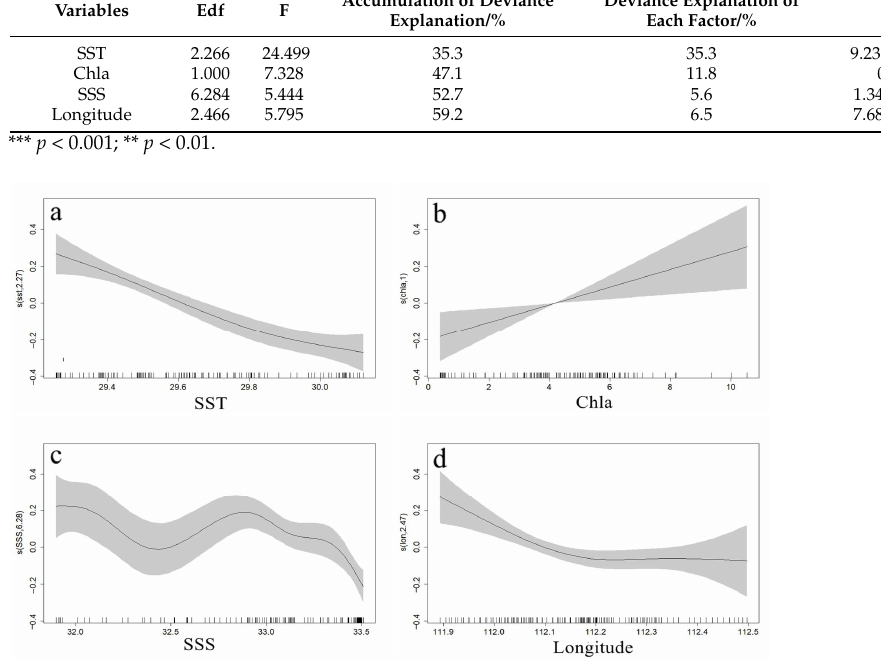
Figure 6. Effects of variables on fish density in the optimal model. ( a ) SST, ( b ) Chla, ( c ) SSS, ( d ) Longitude. s(x) is the spline smooth function in the y -axis, the values represent degree of freedom, and shaded areas indicate the 95% confidence interval.